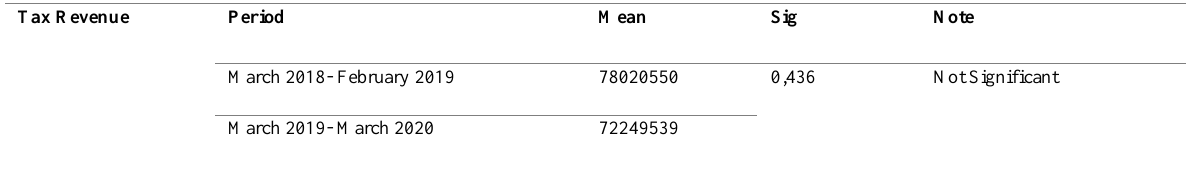
Table 1: Result of Hypothesis One Test